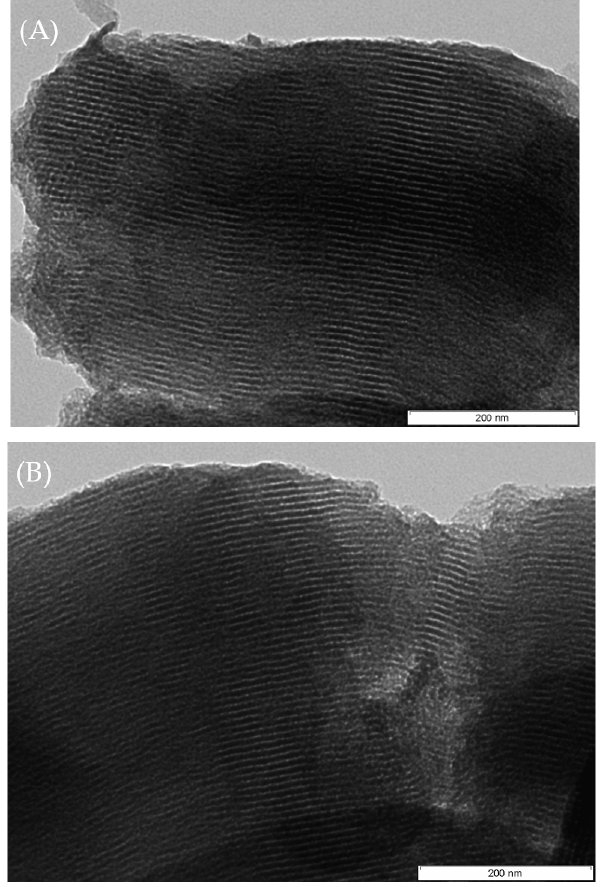
Figure 5. TEM images: ( A ) SBA-15; ( B ) PW4-SBA-15-SO 3 H.